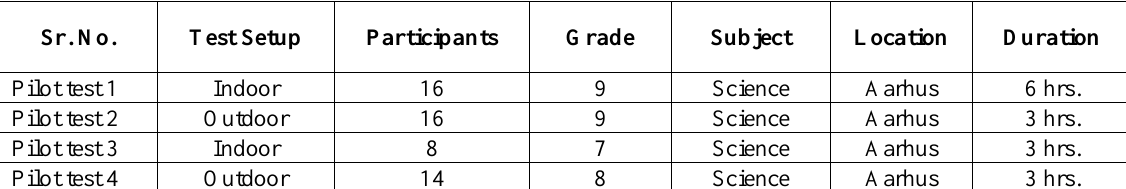
Table 2. Participants’ details in pilot tests with